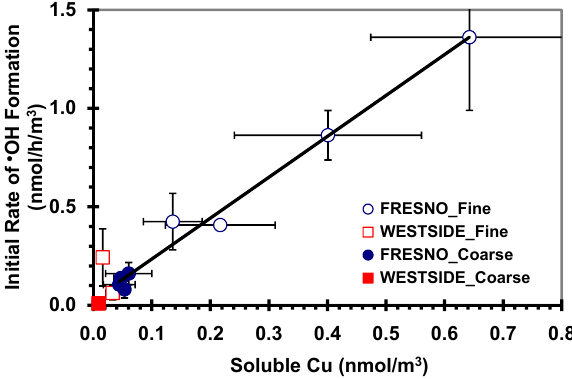
Fig. 7. Inhibitory effect of the transition metal chelator DSF on the initial rate of • OH generation in SLF with ascorbate for the positive control and the SJV PM. Values are means ± SD. n = 4 for extractions without added DSF, and n = 2 to 3 for extractions with added DSF.